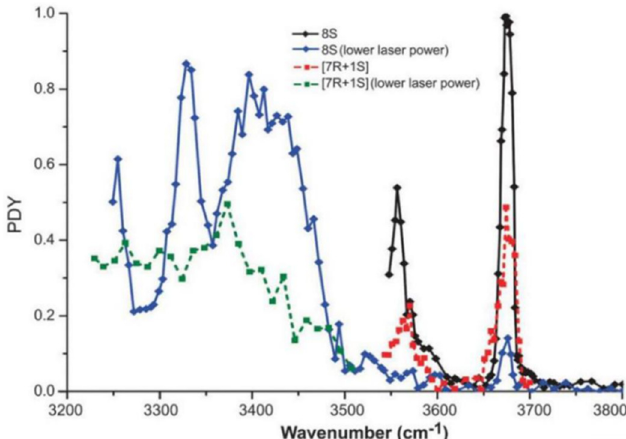
Figure 4. IRMPD spectra of the homochiral protonated serine octamer [8S] (black and blue, solid) and the heterochiral protonated serine octamer [7 R + 1 S ] (red and green, dotted). The black [8 S ] and red [7 R + 1 S ] traces were measured with a higher laser power compared to the blue and green traces [39]. Reprinted with permission from RSC.